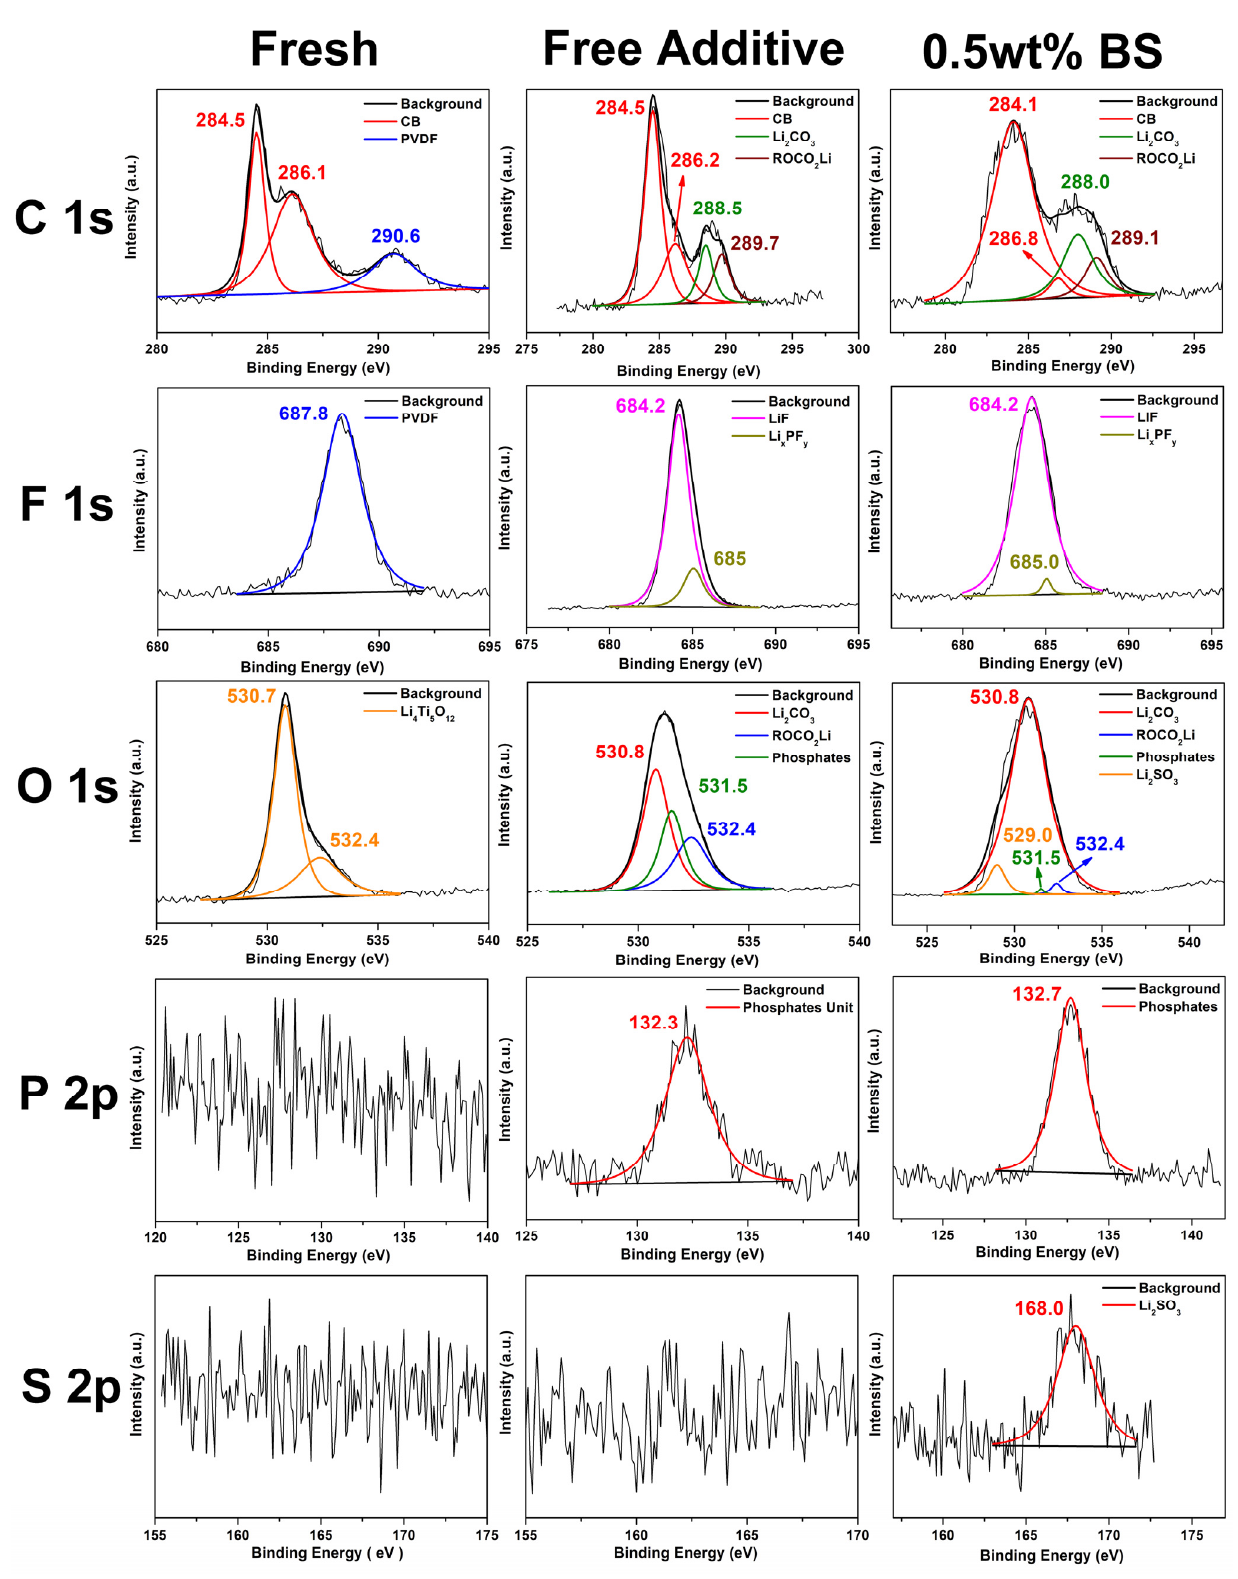
Figure 7. C 1s, F 1s, O 1s, P 2p, and S 2p XPS spectra of the fresh LTO electrode and the cycled electrode, without and with 0.5 wt% BS additive at 0.2 C for 50 cycles.